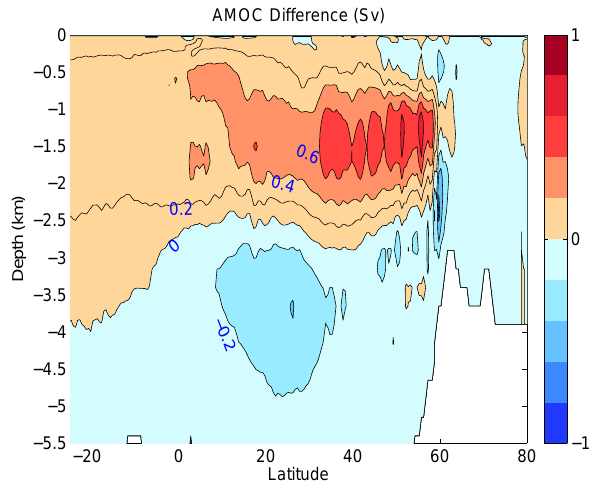
Fig. 20. AMOC difference of a run with river runoff distributed over Fig. 120. AMOC difference of a run with river runoff distributed 400km distance from a run with a 100km distribution distance. The over 400km distance from a run with a 100 km distribution dis- results are the last 10yr mean in a 60yr tance. The results are the last 10 yr mean in a 60 yr simulation.